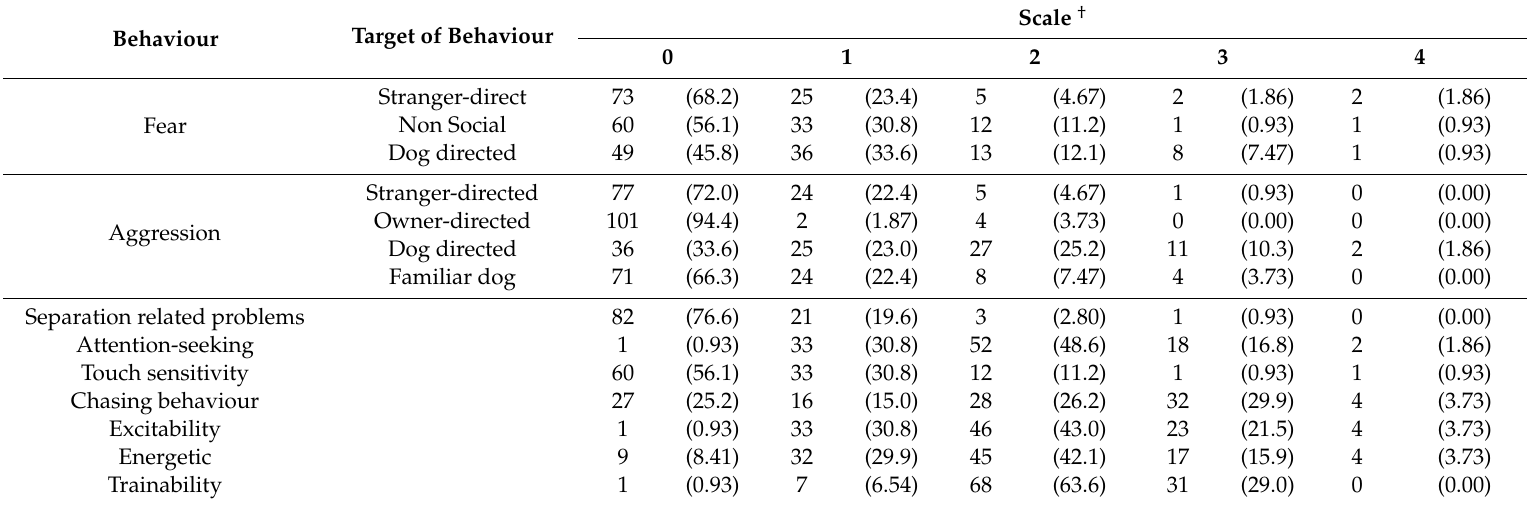
Table A2. Number (and %) of respondents (n:107) classifying their dogs in each of five levels on a scale of increasing intensity of behaviour exhibited at home, using the C-BARQ